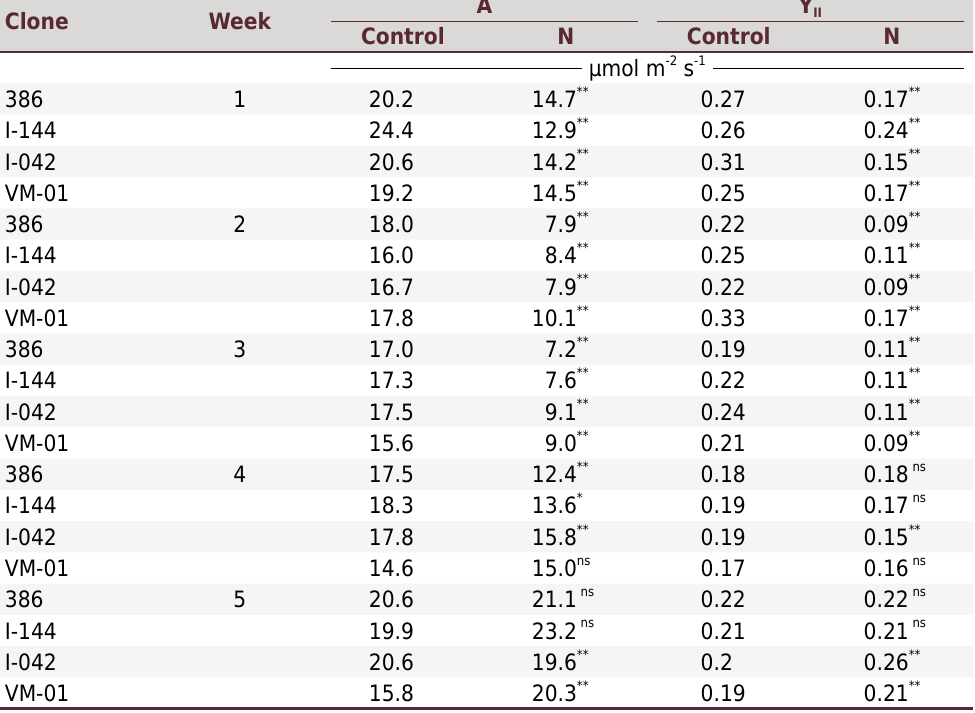
Table 4. The net photosynthesis (A) and effective quantum efficiency of the linear electron flux in photosystem II (Ŷ II ) in Eucalyptus clones subjected to nitrogen omission (weeks 1 and 3) and nitrogen resupply (weeks 4 and 5) and control treatments